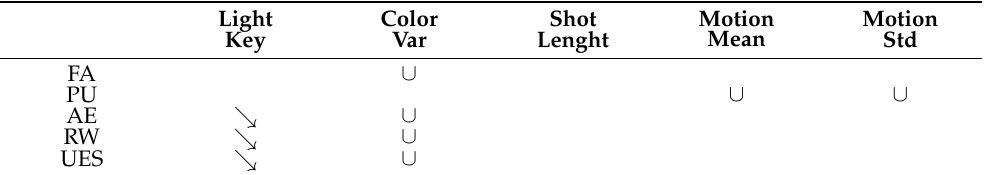
Table 10. Model shapes of four O’Brien UES user engagement scale dimensions estimated from 5 low- level ad video features. The foreseen possible model shapes are labelled with symbols ∪ representing U-shape, ∩ indicating upside-down U shape, (cid:37) showing increasing and (cid:38) for decreasing behaviour. Shot Motion Light Color Mean Var Key Lenght